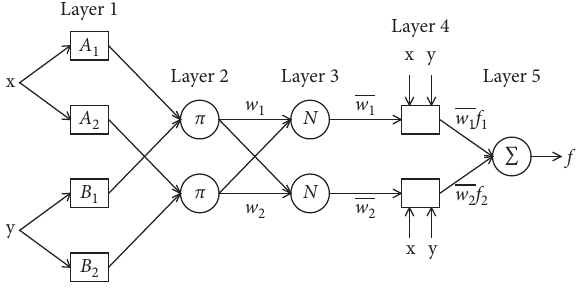
Figure 3: Structure of the ANFIS